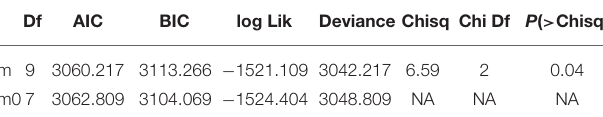
TABLE 3 | Summary of model fit